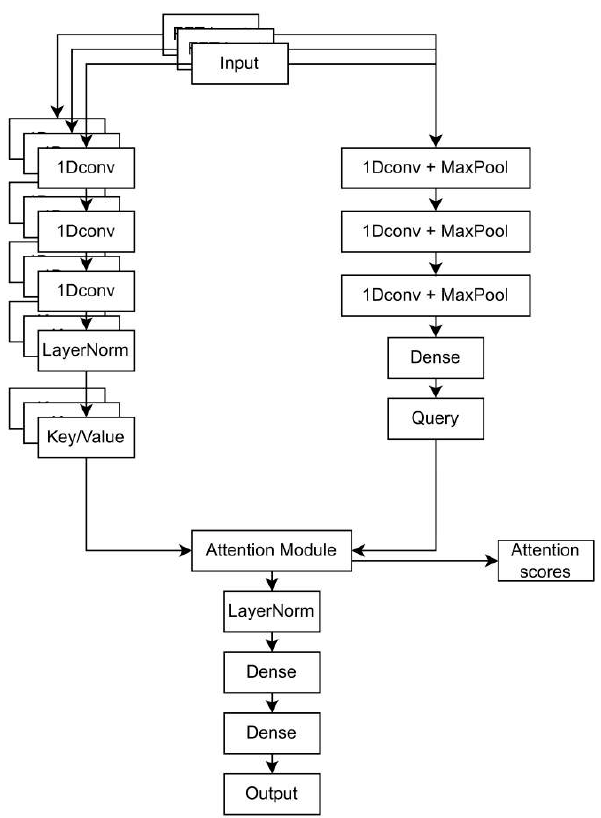
Figure 1. Scheme of the DNN architecture adopted to address the OSP